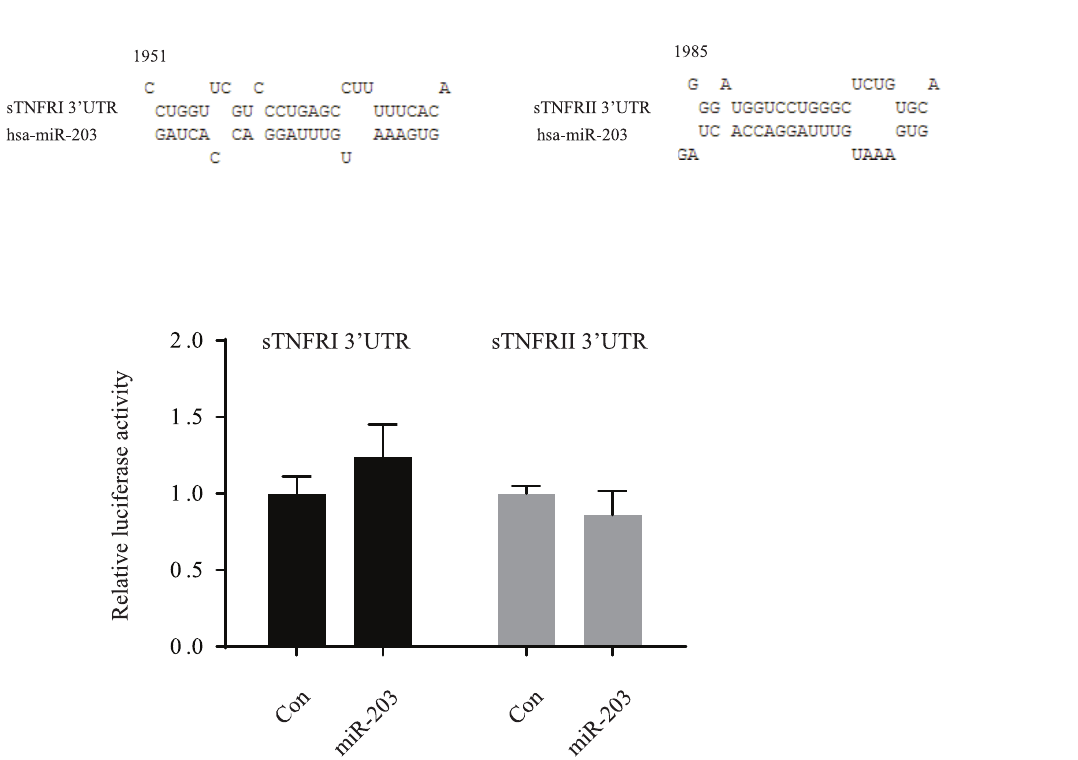
Fig. 5. Putative targets by miR-203. A . Predicted miRNA sequences and their putative recognition sites within 3 9 UTR of sTNFRI (NM_001065) and sTNFRII (NM_001065). B . Luciferase activities of sTNFRI and sTNFRII mRNA 3 9 UTR were not affected by miR-203. 293Tcells were transfected with pGL3 vectors containing sTNFRI and sTNFRII, and Renilla luciferase expression vector, and followed the treatment of precursor miR-203 oligos and control oligos. Firefly luciferase activity was measured and normalized to the activity of Renilla luciferase.